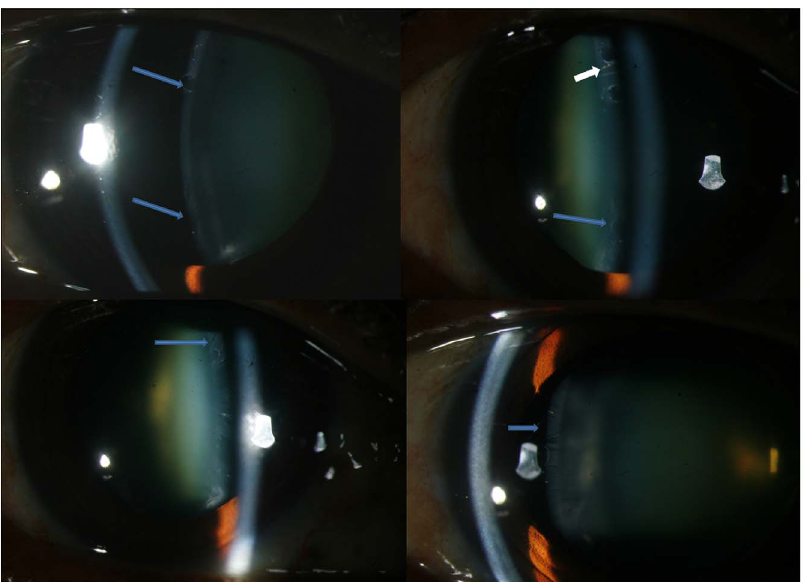
Figure 2. Slit lamp photograph showing atypical features of classical pseudoexfoliation like circularly shaped empty spaces (Top left &right, bottom left and right) which are seen extending from the periphery to the centre interspersed with pigment deposits (white arrow in top right).